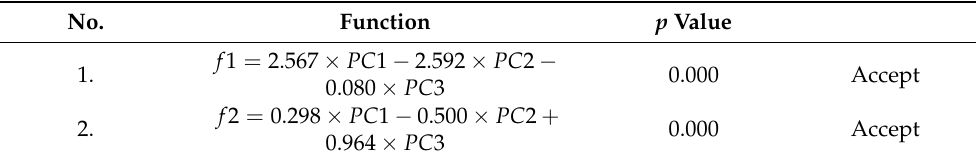
Table 6. Derived functions and validation from LDA analysis for RS.